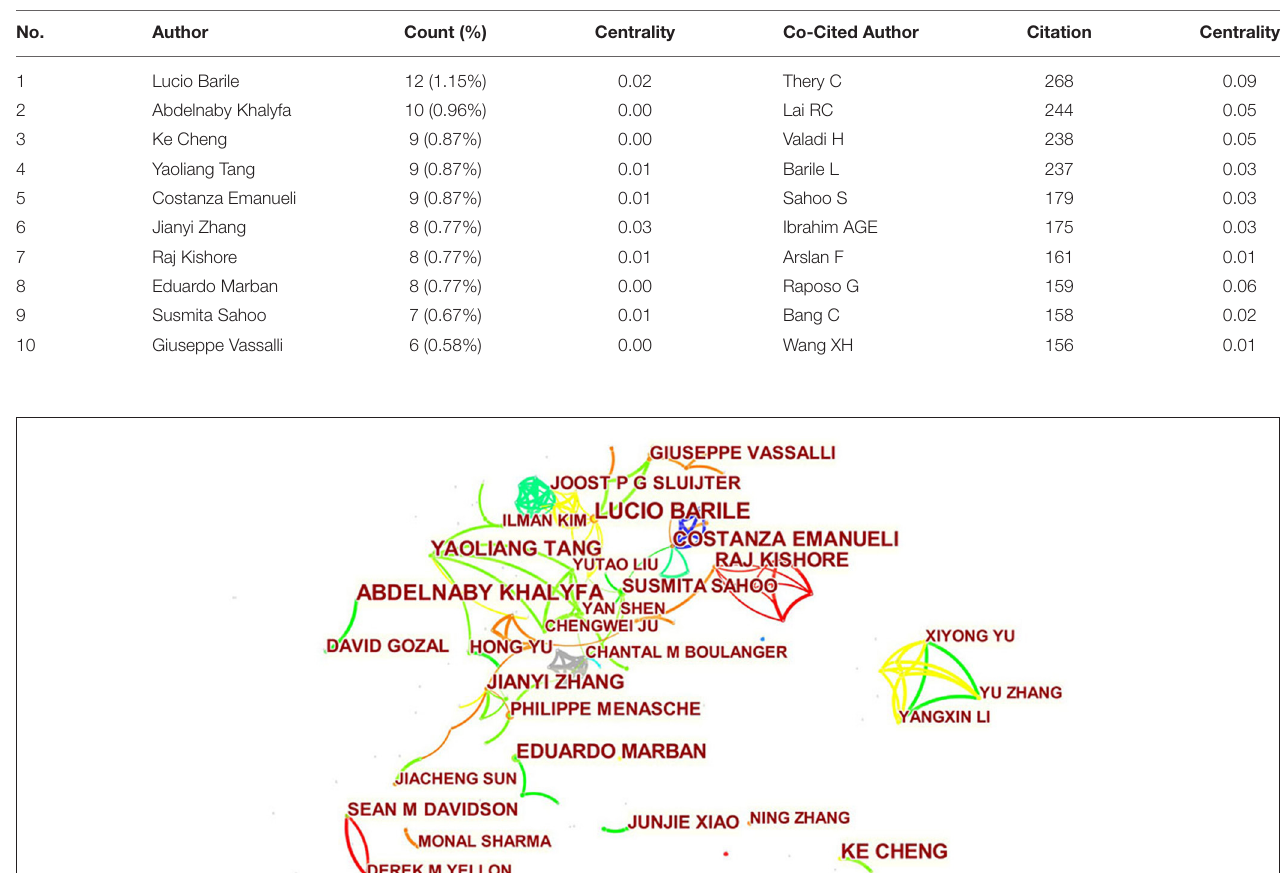
TABLE 3 | Top 10 authors and co-cited authors related to exosomes in CVDs.